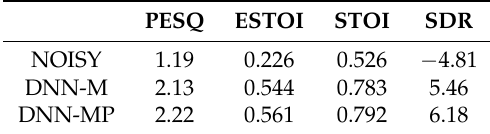
Table 4. Experiment 3-2: Effect of phase-aware training target on DNN-MP . PESQ ESTOI STOI SDR